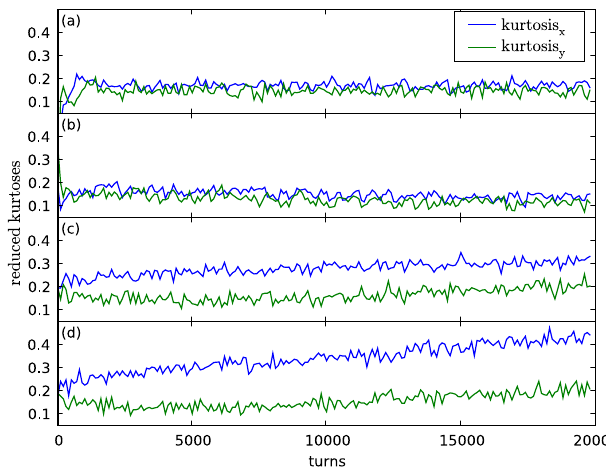
FIG. 11. (Color) The evolution of (reduced) kurtosis of the particle distribution for